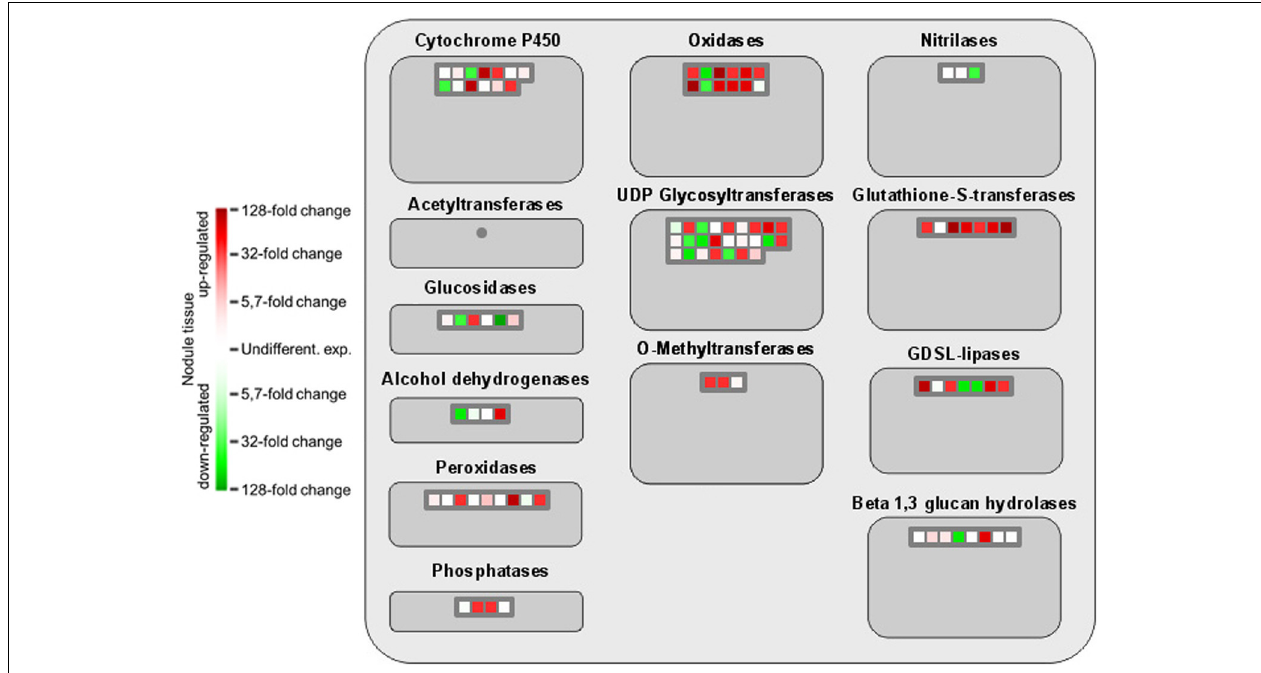
FIGURE 4 | MapMan-based classification of the expressed genes into large enzyme families. Each field represents the expression of a particular gene. Upregulated genes in nodule tissue are shown in red, genes with